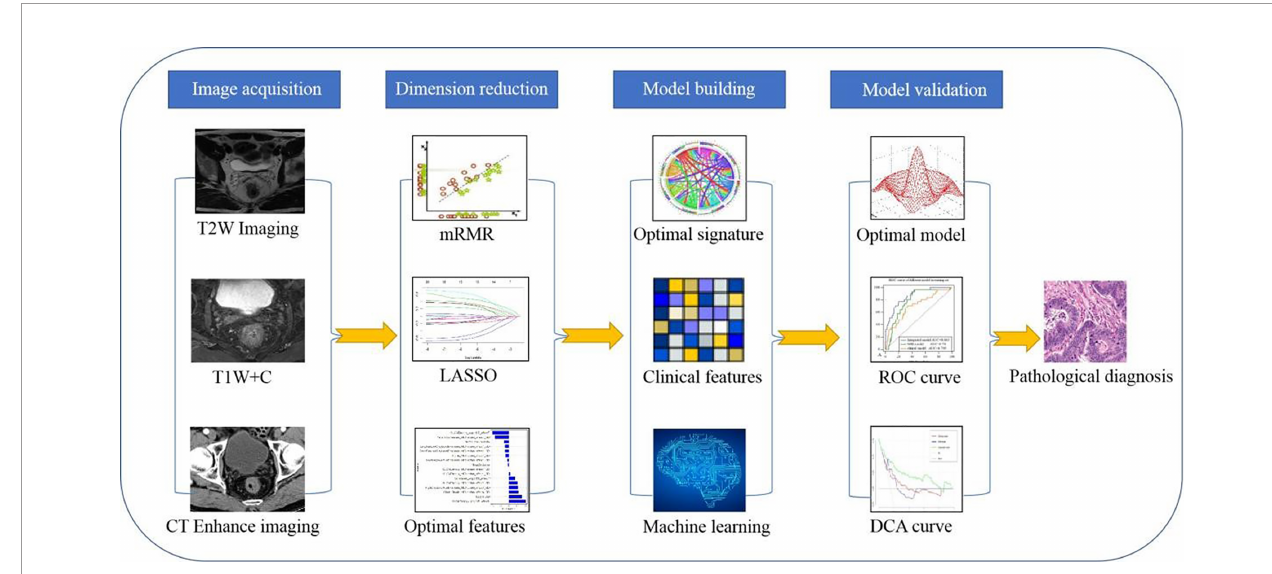
FIGURE 1 | Research fl ow chart of the radiomics